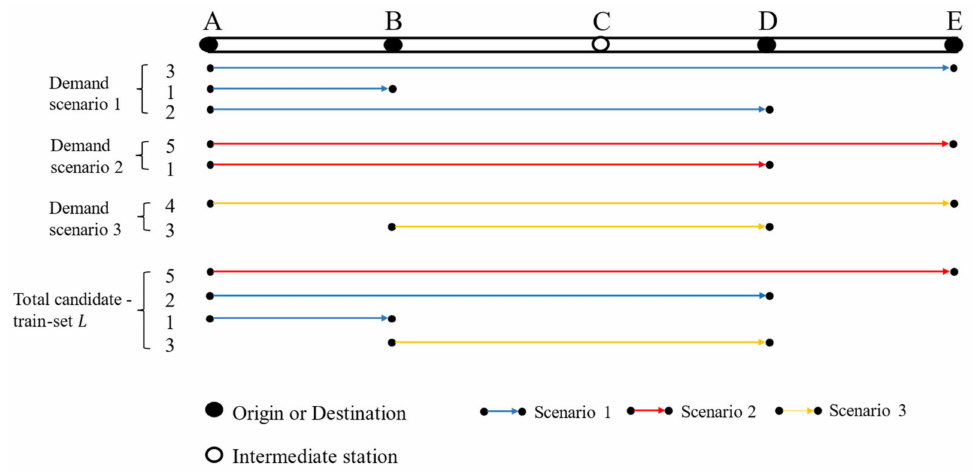
Figure 3. The diagram of a candidate train set generation for a given